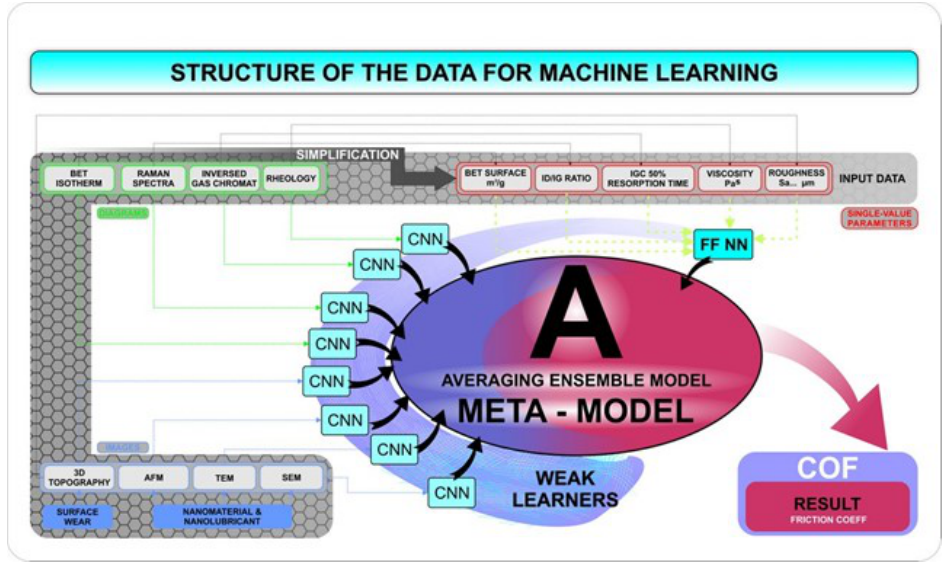
Figure 9. The general concept of the machine learning algorithm to predict the coefficient of friction and nanolubricant